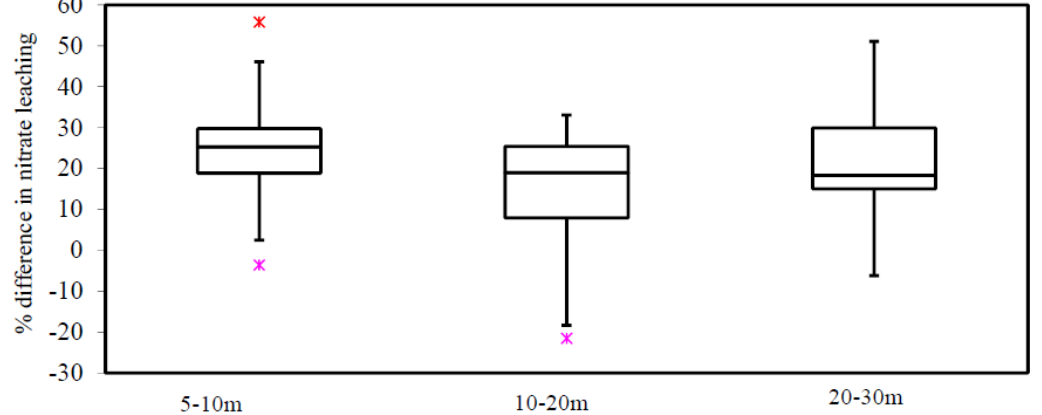
Figure 12. Figure showing more nitrate leaching with narrow increase in tile drain space in continuous corn (two journal articles were considered for analysis).